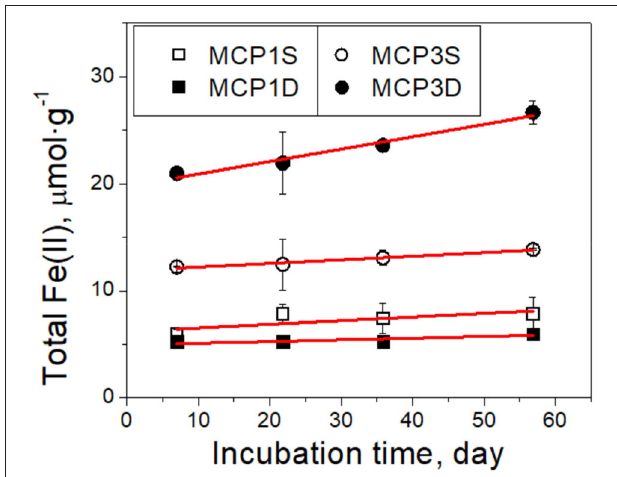
FIGURE 3 | Kinetics of total Fe(II) production over time in incubation experiments. Black symbols are the experimental data, and red lines are the fitted results with the zero-order rate (Equation 2). The error bars represent one standard deviation from duplicate